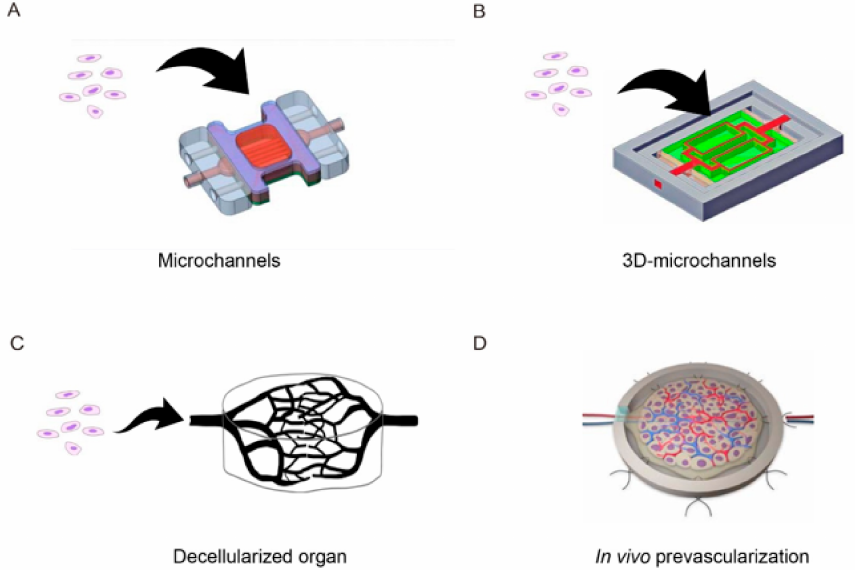
Figure 3. Technologies available for the induction of capillaries in bioengineered tissue. ( A ) A microfluidic system is used to introduce artificial capillaries (microchannels) within the tissues that are perfused with fluid. ( B ) A microfluidic system based on the creation of a scaffold that imitates a 3D microcirculatory structure. Vascular endothelial cells are seeded on the luminal side of the scaffold and perfusion culture is performed. ( C ) A whole organ is decellularized and vascular endothelial cells are seeded into the original vascular structure and subjected to perfusion culture so as to reproduce a circulatory system. ( D ) Engineered tissue is implanted onto well-vascularized host tissue to induce the growth of capillaries into the graft. The host tissue is supplied by blood vessels that are suitable for anastomosis onto other blood vessels, enabling later transplantation of the vascularized graft to the desired site. The schematic diagram was drawn with the graphic design software, Adobe